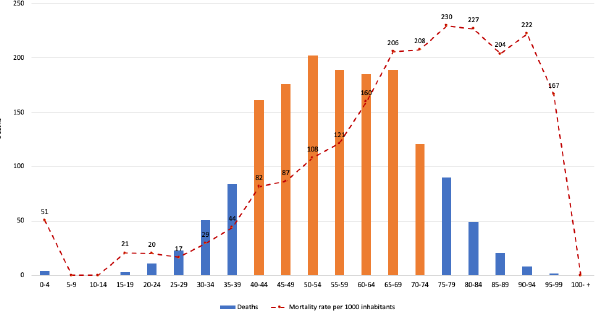
Figure 9. Deaths and mortality rate by age groups as of April